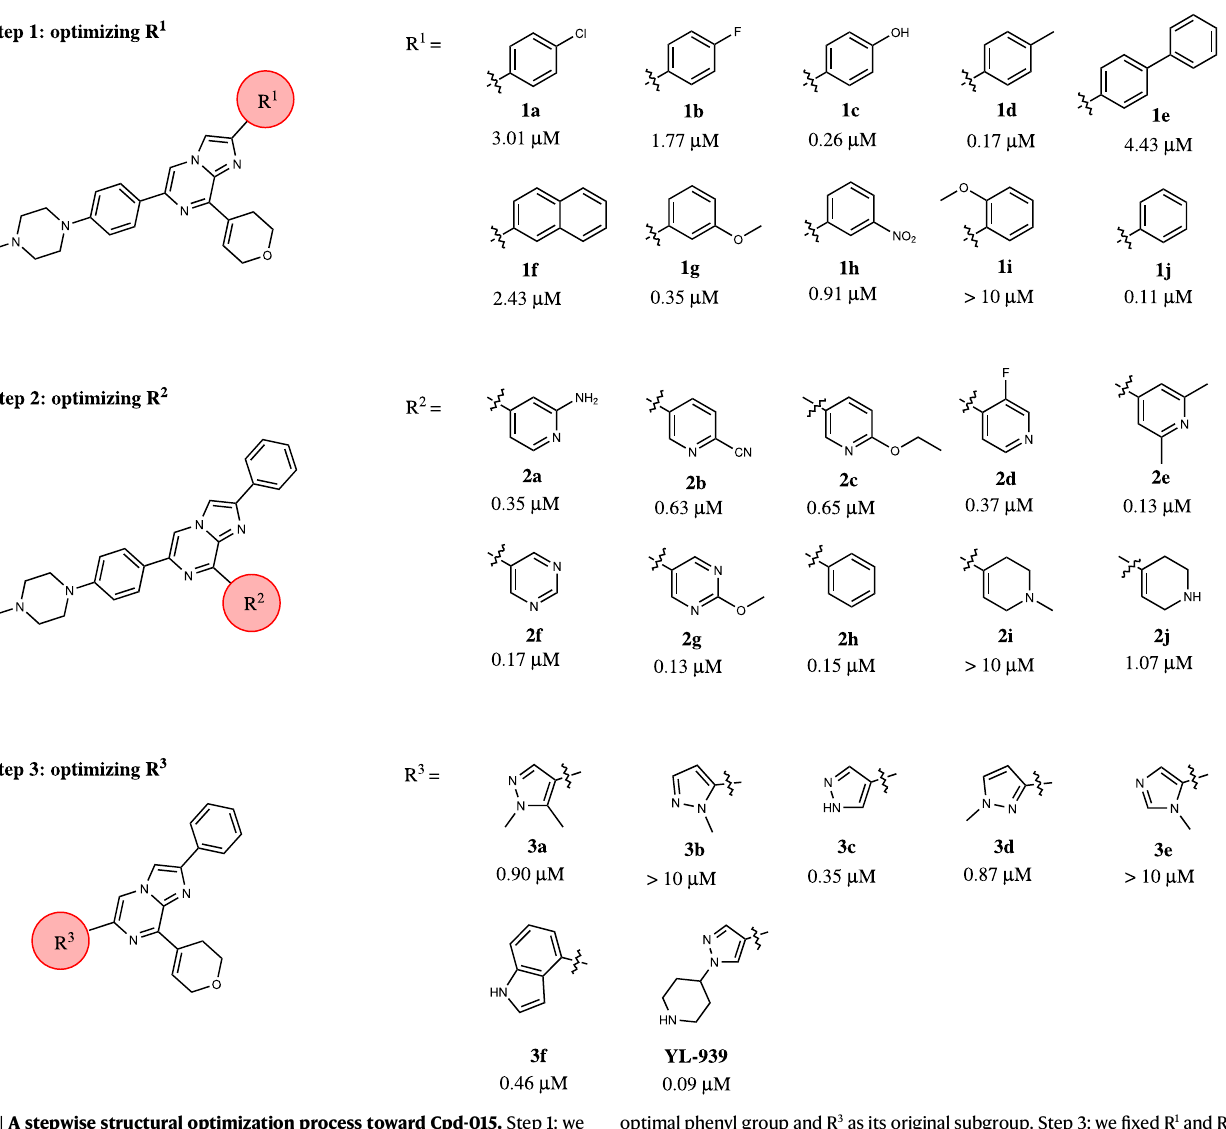
optimal phenyl group and R 3 asits original subgroup. Step 3: we fi xed R 1 and R 2 as their optimal subgroups and optimized R 3